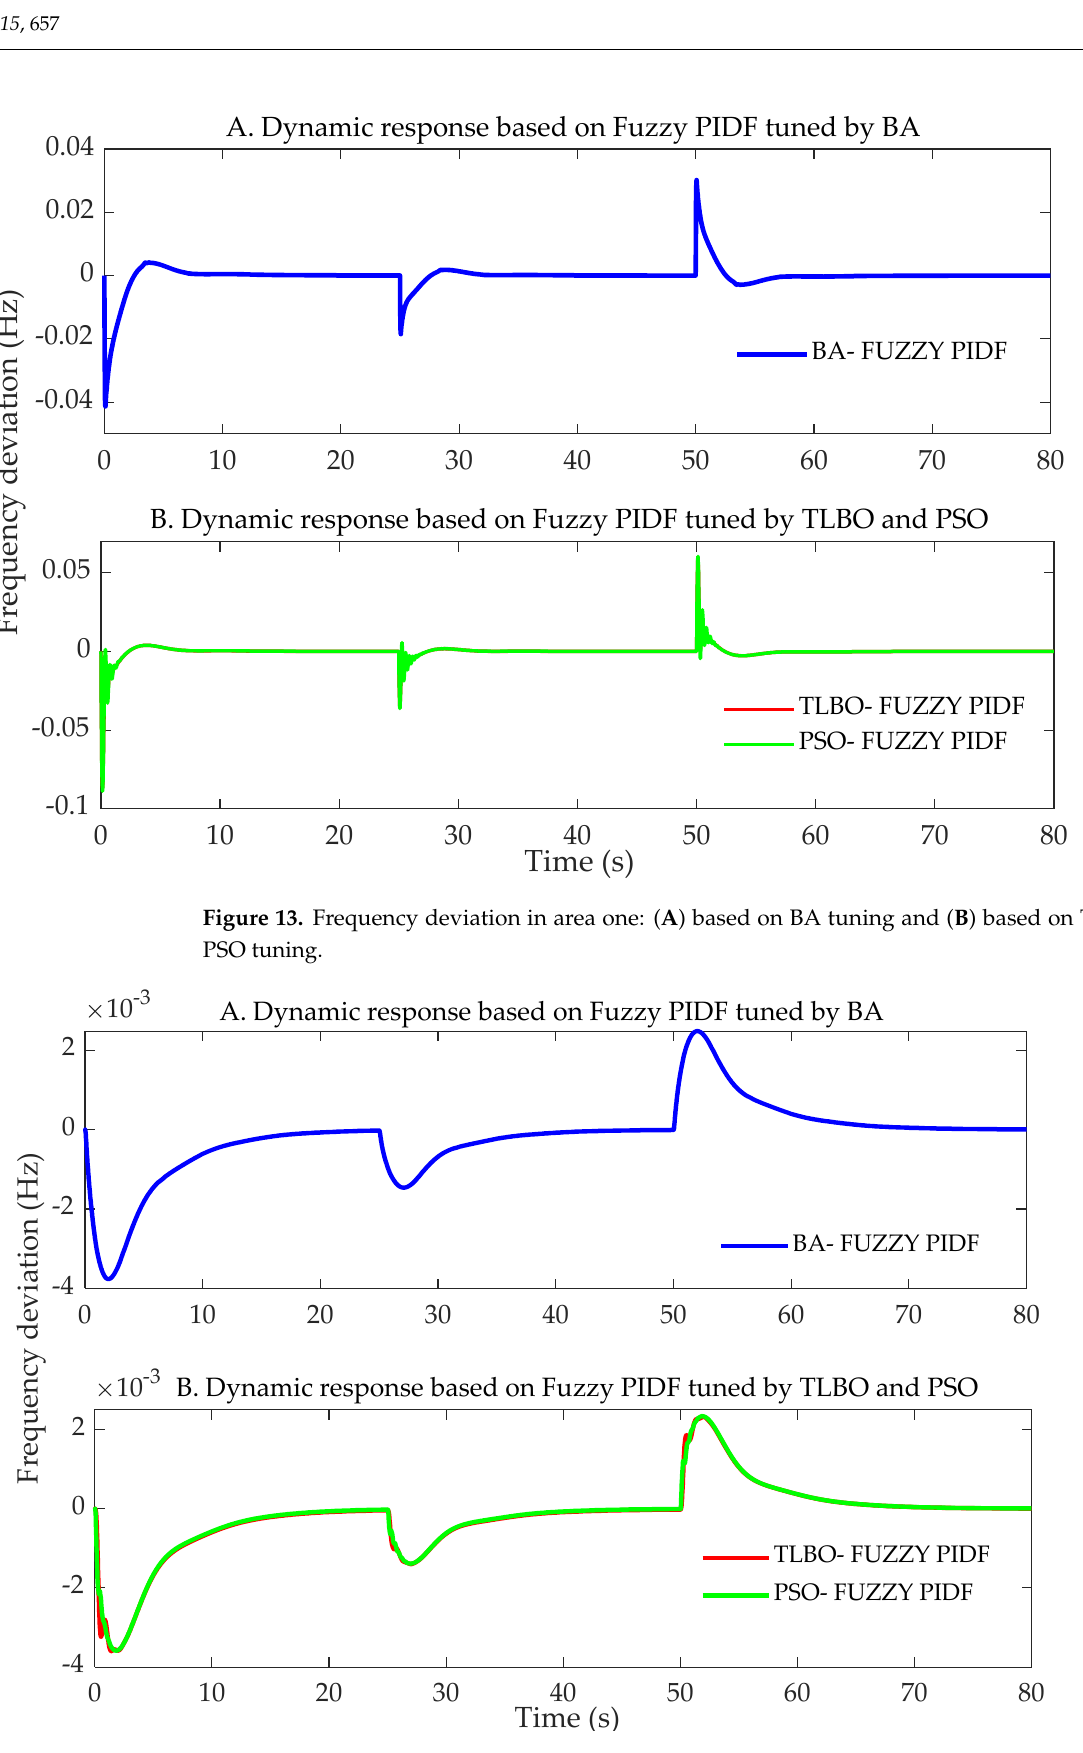
Figure 14. Frequency deviation in area two: ( A ) based on BA tuning and ( B ) based on TLBO and PSO tuning.